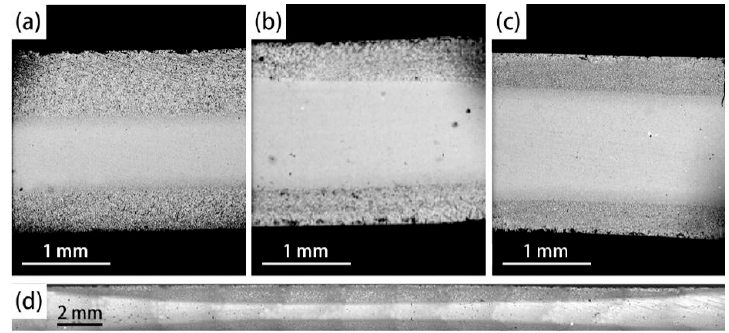
Figure 2. Longitudinal cross-sections of the same area in the FeCoCrNiMo HEA samples sintered at 1150 °C under different pressures: ( a ) 30, ( b ) 35, and ( c ) 40 MPa, as well as ( d ) the macrostructure of the 30 MPa sintered sample.